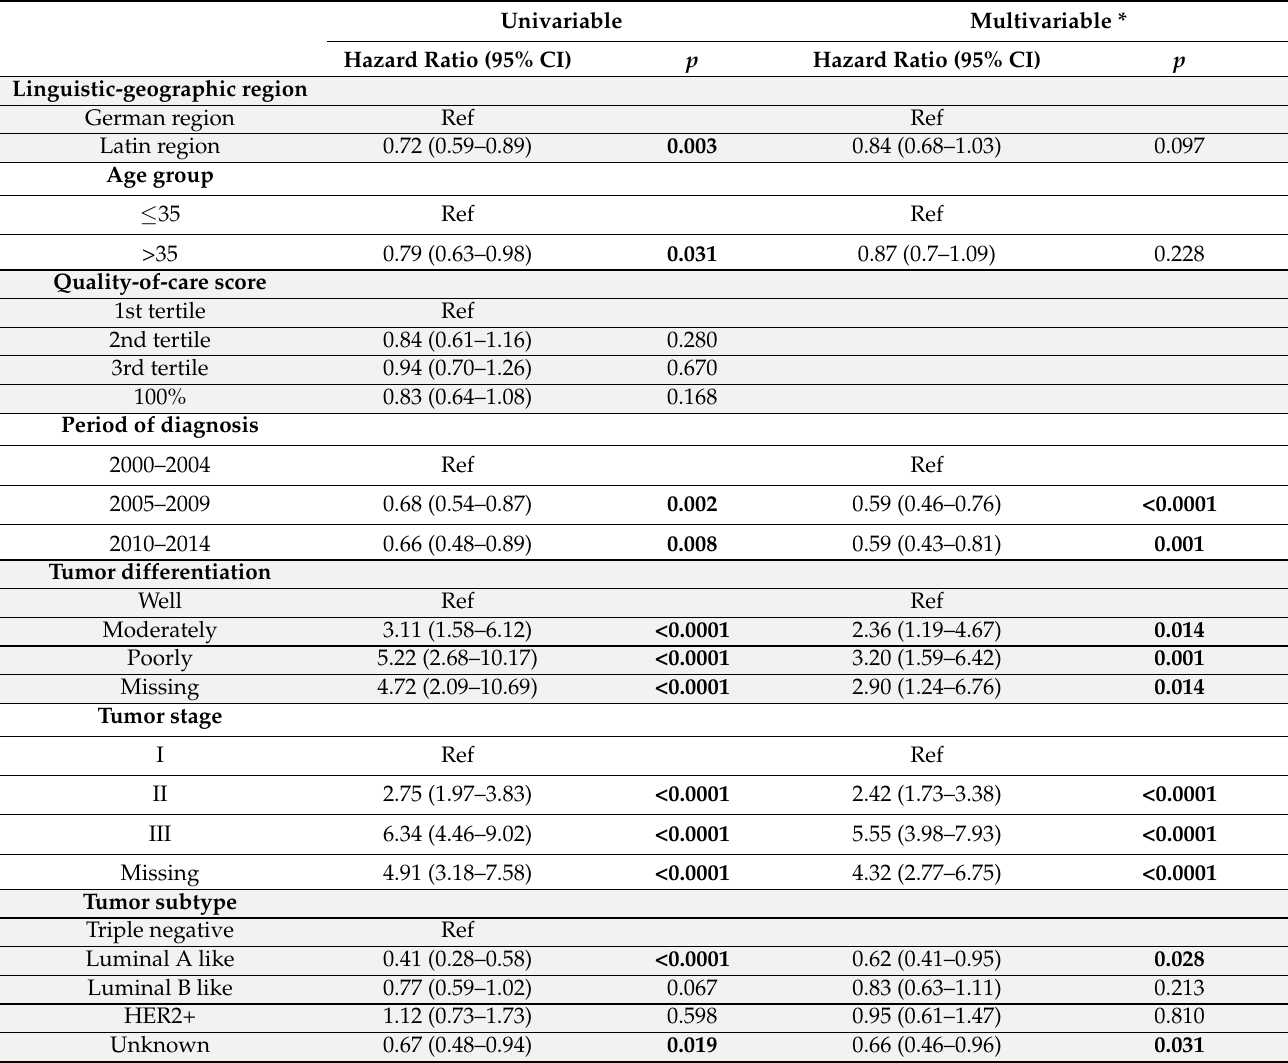
Table 4. Univariate and multivariable associations between clinicopathological factors and over- all